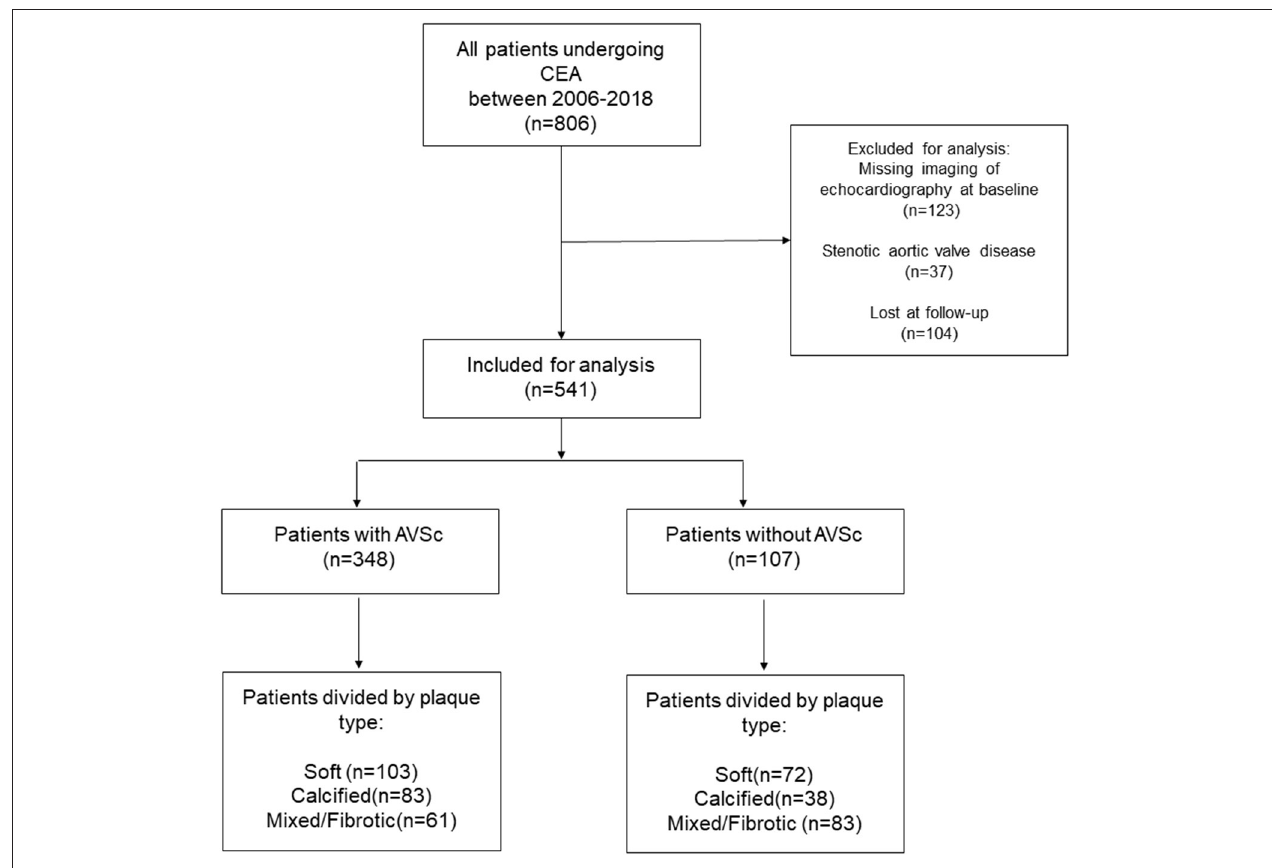
FIGURE 1 | Patient flow chart. The number in the brackets indicates the number of patients. AVSc, aortic valve sclerosis; CEA, carotid endarterectomy.